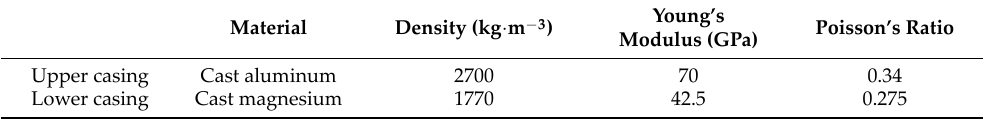
Table 1. Material properties of the casing.